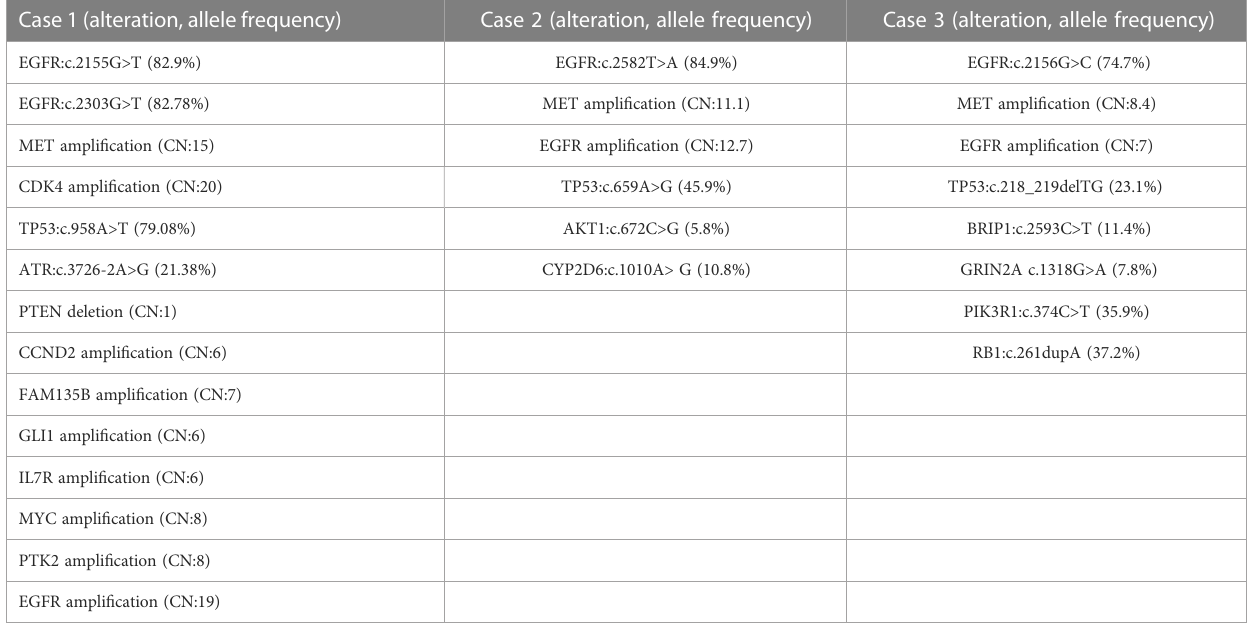
Concurrent alterations identi fi ed in